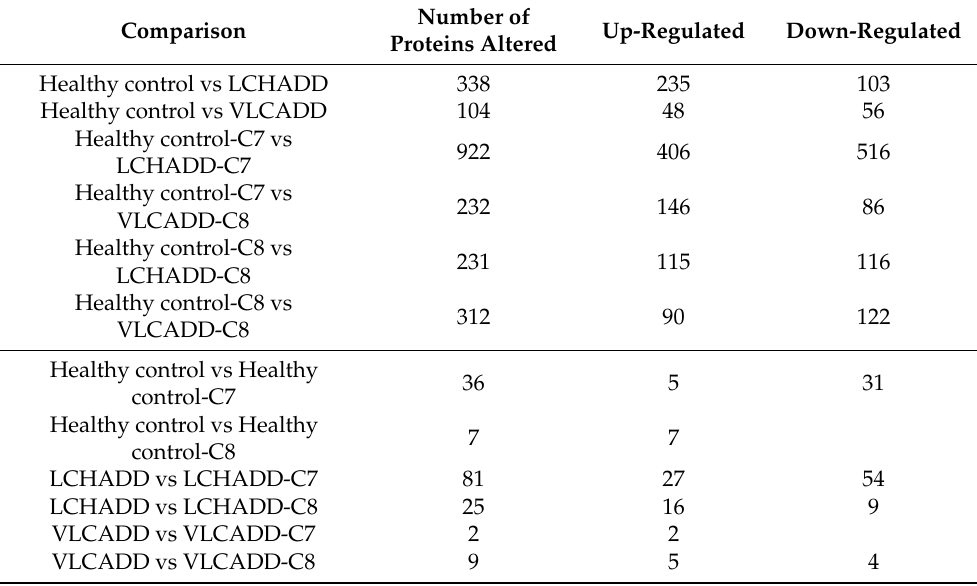
Table 2. Number of altered proteins in fibroblasts from healthy controls and from VLCADD and LCHADD patients either under control conditions or after incubation with C7 or C8 detected by proteomic